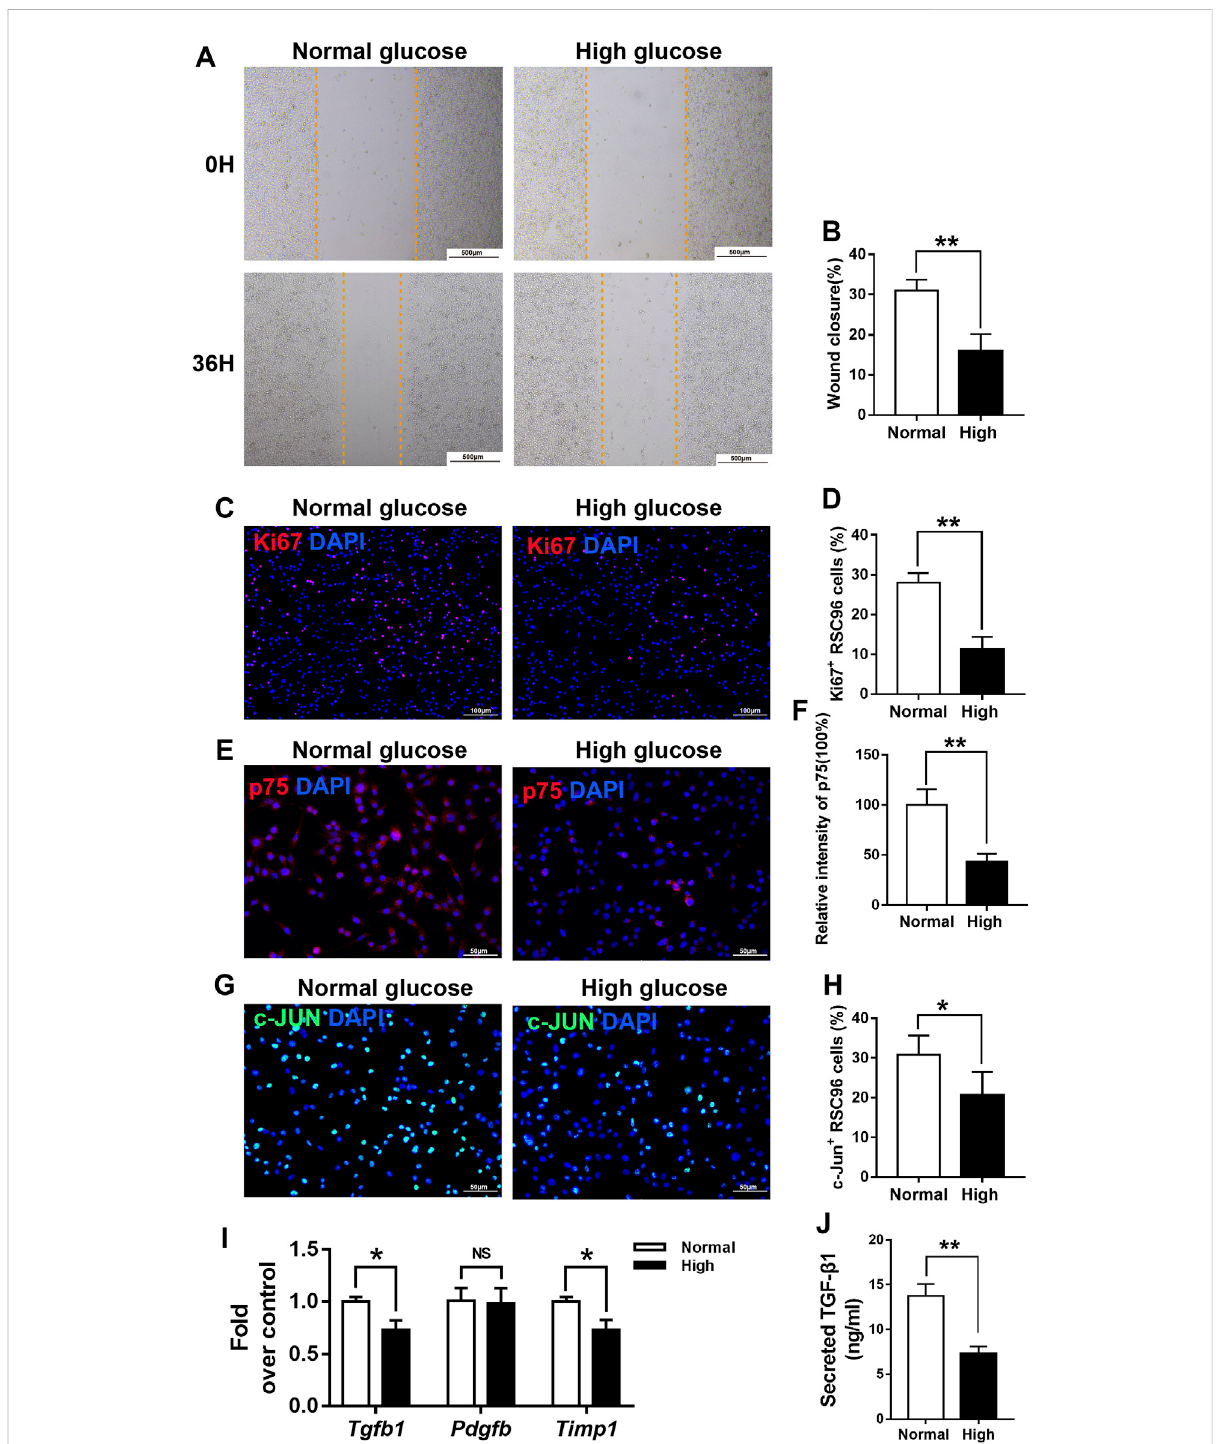
FIGURE 7 High glucose reduces the viability and de-differentiation of SCs in vitro . (A,B) A scratch assay of RSC96 cells treated with 5.5 mM glucose (normal) or 50 mM glucose (high) for 0 or 36 h (C – H) Representative immuno fl uorescence analyses of Ki67 (C) , p75 (E) , and c-Jun (G) in cells incubated with normal or high concentrations of glucose for and the percentages of Ki67 + cells (D) , p75 + cells (F) , and c-Jun + cells (H) in the two groups. (I) Real-time PCR analysesof the expressionlevelsof Tgf- β , Pdgfb , and Timp1 in the normal and high glucose groups, expression levels werenormalized to those of Gapdh . (J) ELISA analysesofthe expression levels of TGF- β 1in thenormal and high glucose groups. Data are presented as mean ± SD of three independent experiments, ** p < .01 and* p < .05, Student ’